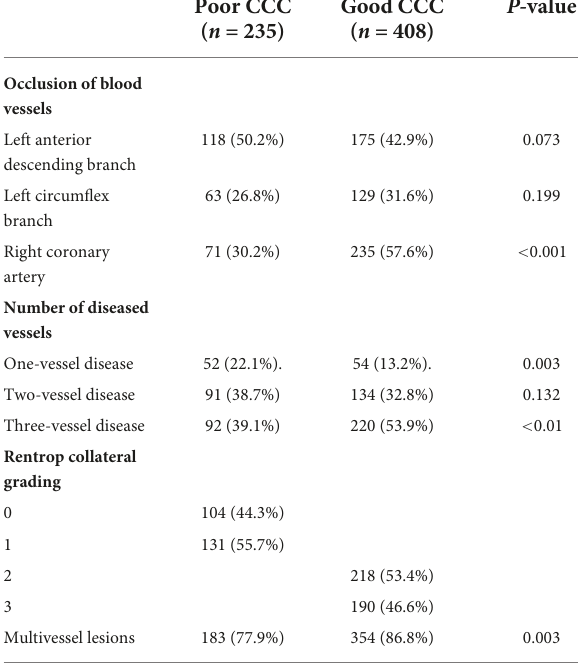
TABLE 3 Comparison of coronary angiographic characteristics between the two groups.